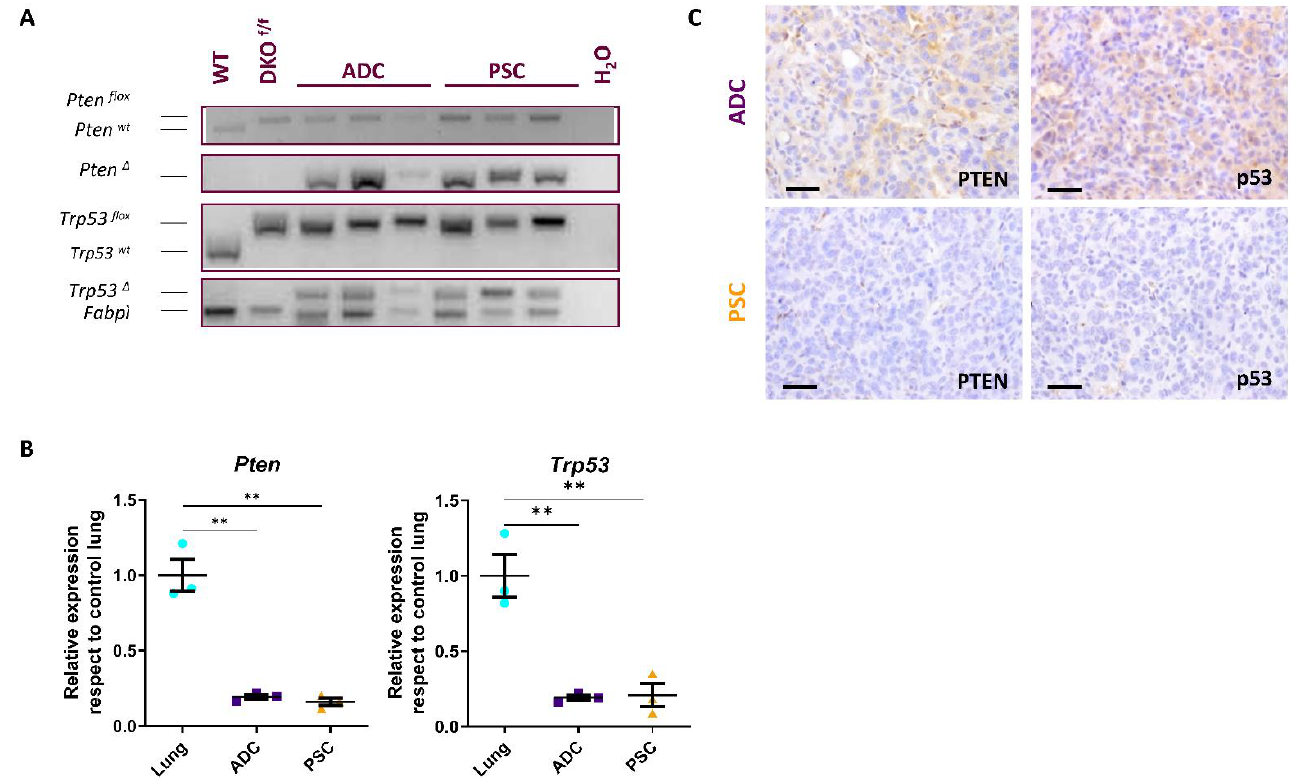
Figure 3. Deletion of Trp53 and Pten in adenocarcinoma (ADC) and pulmonary sarcomatoid car- cinoma (PSC) arisen in CMV-DKO and K5-DKO mice. ( A ) PCR analysis of Trp53 and Pten floxed genes confirms the deletion in double mutant tumors of the Pten and Trp53 gene. WT: wild type mouse lung, DKO F/F : uninfected Trp53 F/F ;Pten F/F mouse lung. Pten w t and Trp53 wt : Pten and Trp53 wild type alleles. Pten flox and Trp53 flox : Pten and Trp53 floxed alleles. Pten ∆ and Trp53 ∆ : Pten and Trp53 deleted alleles. Fabpi : loading control. Original image of PCR can be found at File S1. ( B ) qRT-PCR analysis of Trp53 and Pten expression levels in double mutant tumors (ADC and PSC) and control lungs (lung n = 3; ADC n = 3; PSC n = 3). ** p < 0.01, determined by t -test. Tbp was used as a house- keeping gene. ( C ) Immunohistochemical analyses of PTEN and TP53 showing the absence of protein staining in ADC and PSC. Bars = 50 µm.